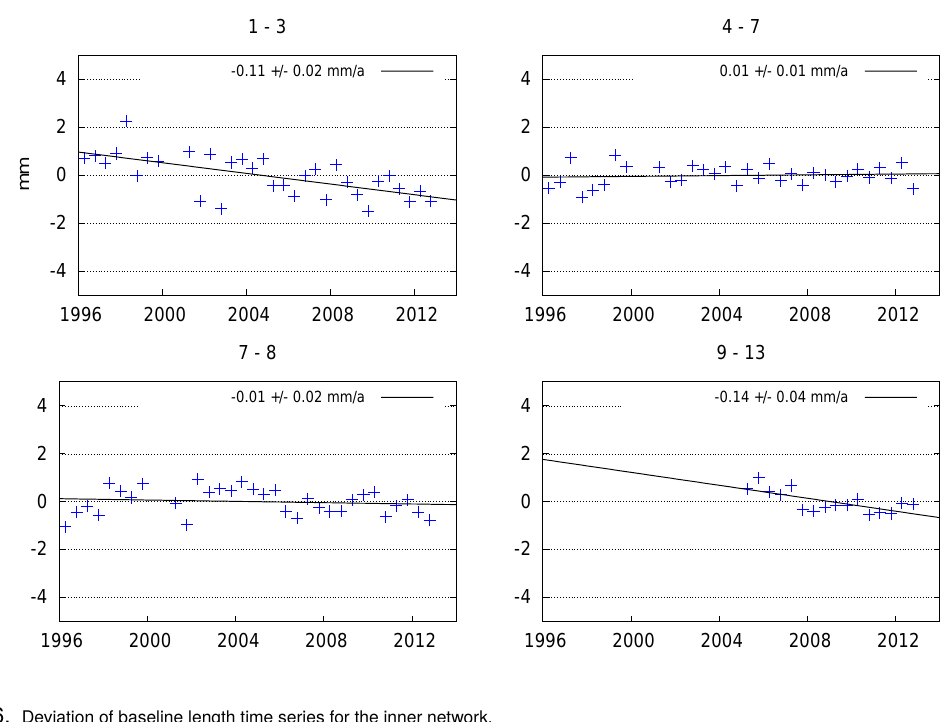
Figure 6. Deviation of baseline length time series for the inner network.